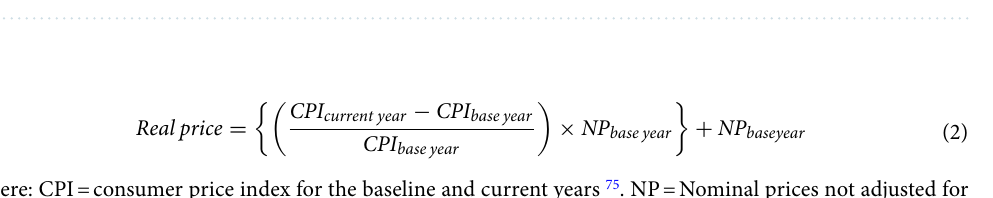
Table 4. Real prices ($/t) for crops across a range of representative environments in Australian irrigated cropping regions. Price ranges were specified from 1992 to 2022 using data sourced from ABARES 16 and ABS 33